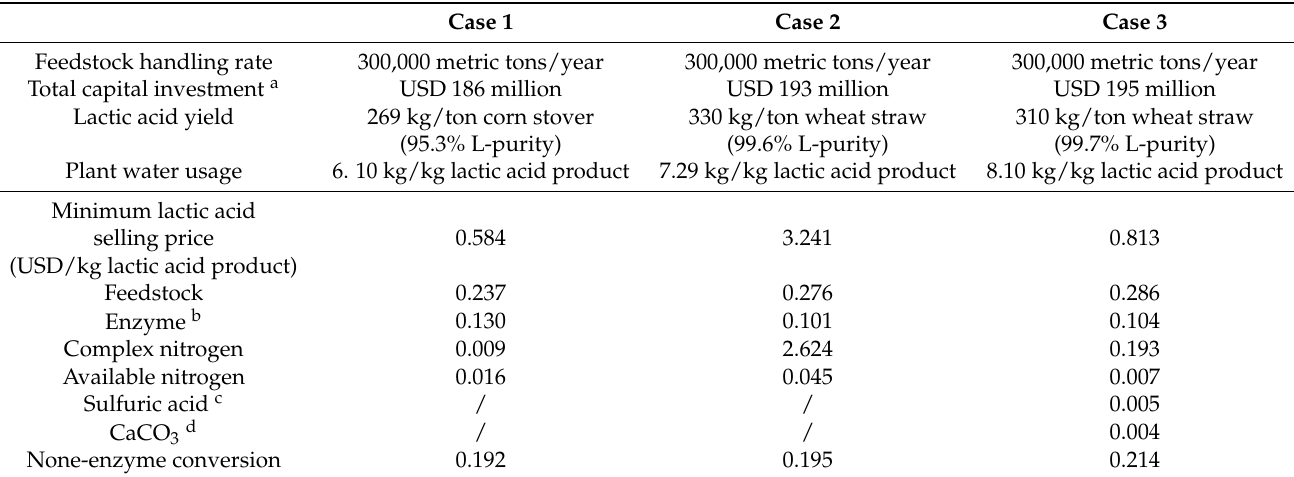
Table 6. Economic evaluation of lactic acid production in different